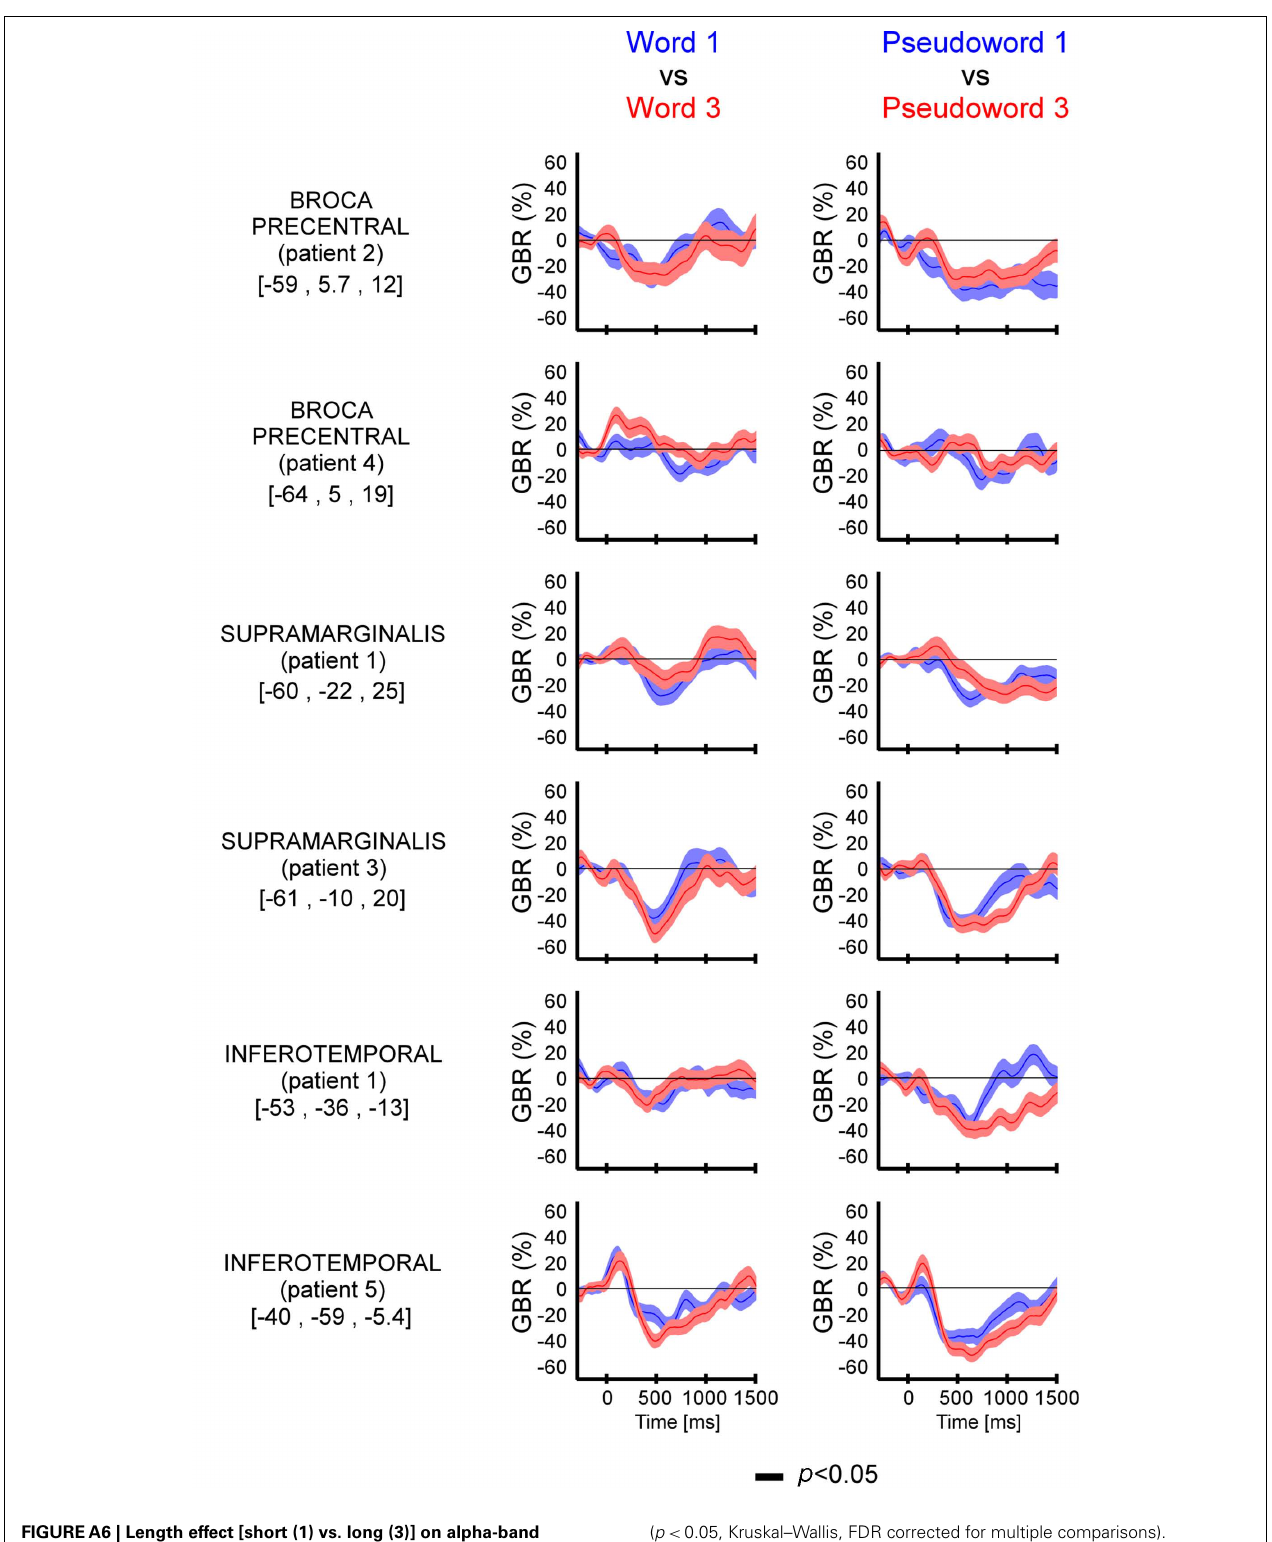
FIGUREA6 | Length effect [short (1) vs. long (3)] on alpha-band responses recorded in ITOC, Broca’s, and SMG across all patients (1–5). The black lines underneath the curves indicates the time samples when the lexical conditions were significantly different